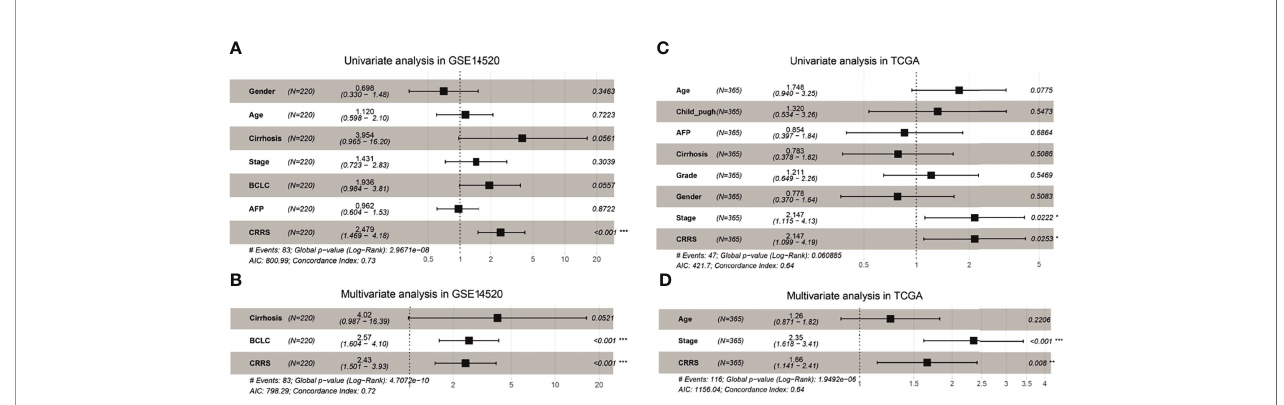
FIGURE 3 | CRRS was an independent prognostic predictor for HCC patients. (A, B) Results of the univariate (A) and multivariate (B) Cox regression analyses regarding OS in the GSE14520 cohort. (C, D) Results of the univariate (C) and multivariate (D) Cox regression analyses regarding OS in TCGA-LIHC